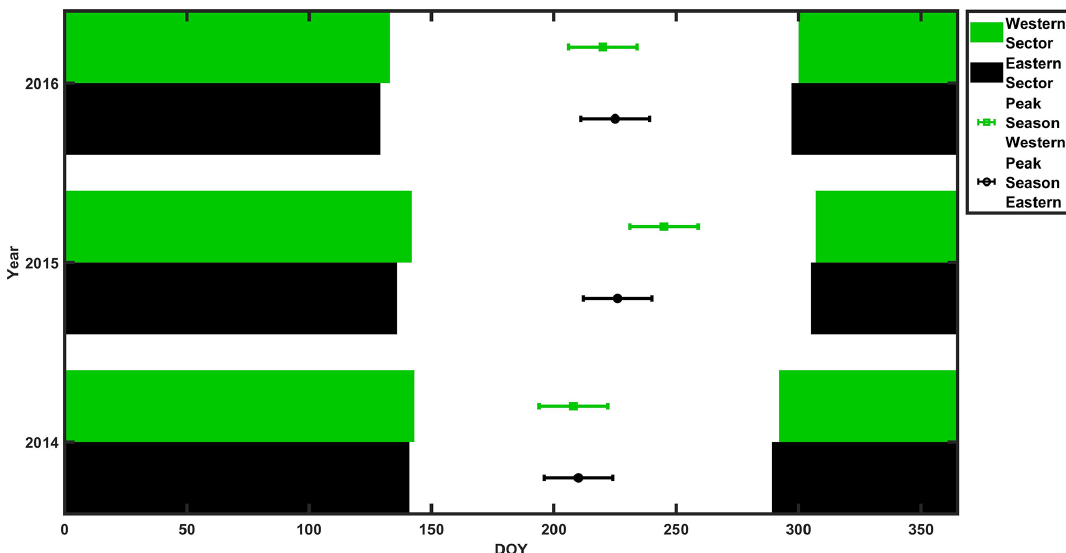
Figure 2. Time periods of frozen peat during the years 2014–2016 (green and black bars) and peak CH 4 emission season (dot with whiskers) for the western sector (green) and the eastern sector (black). (For peak season definition, see Sect.